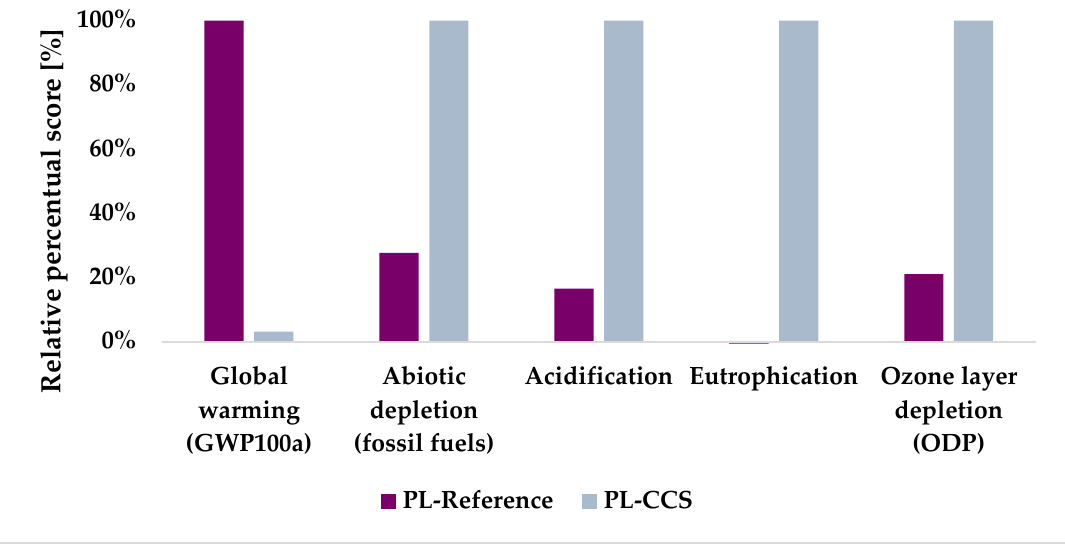
Figure 4. Impact category scores for the Polish case study in the CCS scenario.